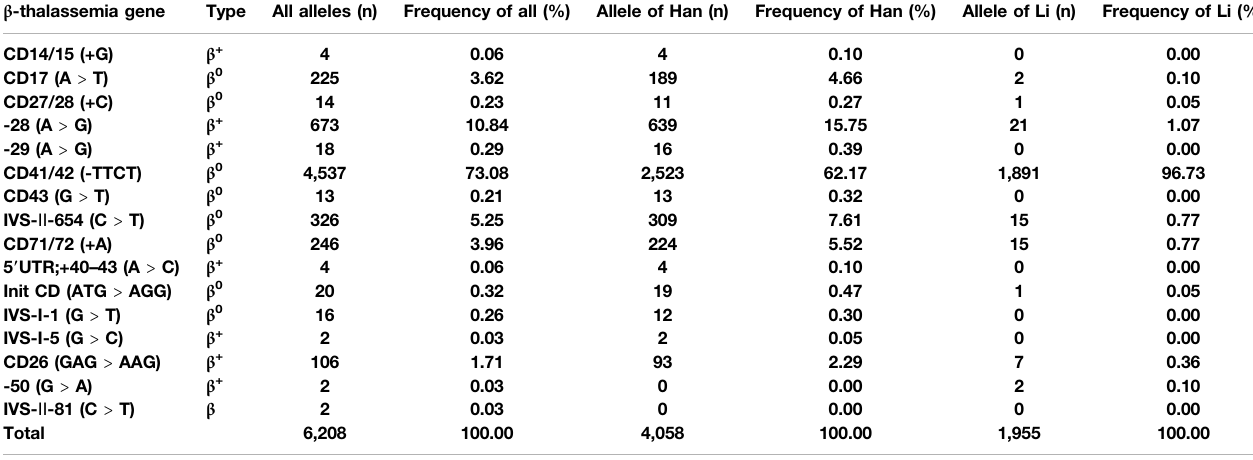
TABLE 4 | Allele frequency of β -thalassemia mutations in the population of childbearing age in the Hainan Island. β -thalassemia gene